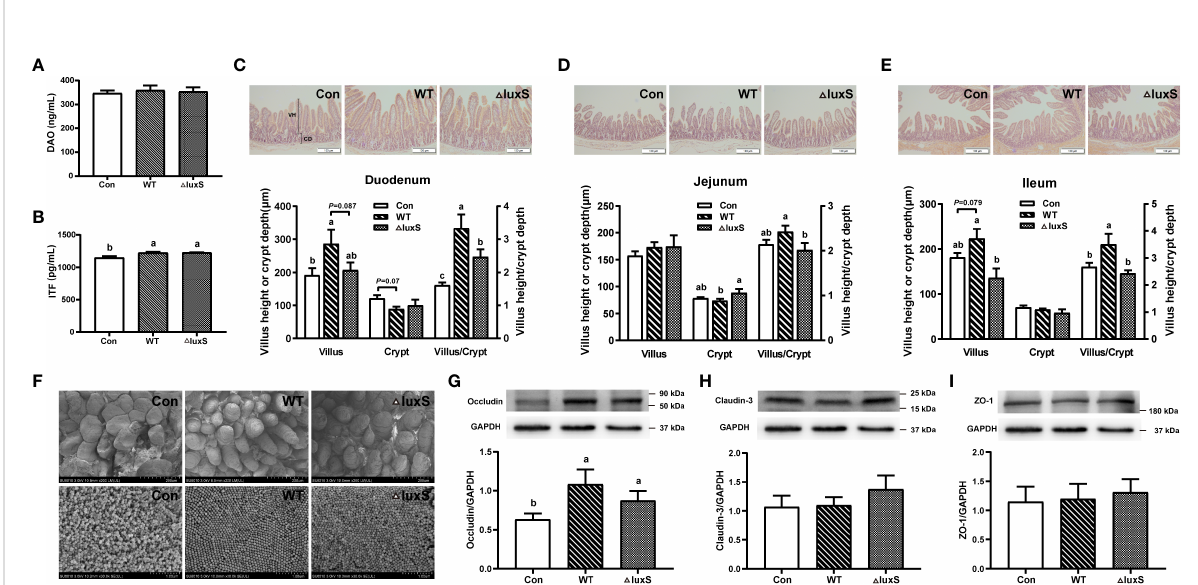
FIGURE 3 Intestinal physical barrier function in weaned piglets. (A, B) DAO and ITF activity in serum of piglet. DAO, diamine oxidase; ITF, intestinal trefoil factor. Intestinal morphology of the duodenum (C) , jejunum (D) and ileum (E) of piglets, scale bars: 100 m m. The villi heights and crypts depths of intestinal segments were measured using Image J software based on at least 25 representatives. The villus length was measured from the villus tip to the villus-crypt junction. The crypt depth was de fi ned as the distance from the base of the crypt to the crypt opening. (F) Scanning electron microscopy visualization of piglet ileum. The upper image is of intestinal villi (200 m m) and the lower image is of microvilli (1 m m). The expression of tight junction protein in ileum was evaluated with western blot, including occluding (G) , claudin-1 (H) and ZO-1 (I) . The protein bands were normalized to the intensity values of GAPDH. WT and D luxS groups were orally inoculated with 2 mL of LGG wild strain and luxS mutant strain, respectively, for 3 weeks before weaning on day 21. Con group was orally inoculated with PBS. Statistical signi fi cance performed using one-way analysis of variance for multiple comparisons. Mean values not sharing common letters are signi fi cantly different ( P <0.05). Values are shown as mean ± SEM,